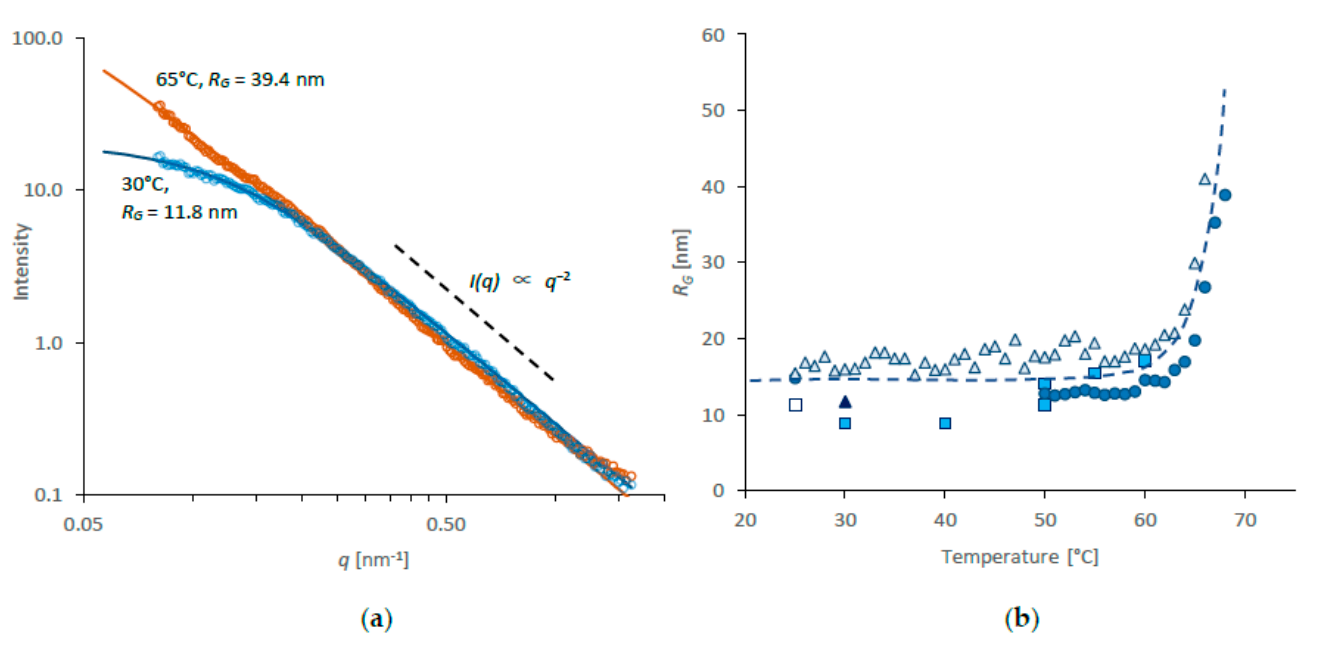
Figure 1. SAXS data for diluted NSF specimens: ( a ) individual markers represent intensity data (on logarithmic axes, to show the most important features) measured at 30 (blue)and 65 °C (brown); the continuous lines represent the Debye model (Equation (1)) with the values of R G shown; the dashed line shows the slope expected for ‘power law’ scattering from a polymer in solution; ( b ) values of R G obtained for diluted NSF during heating; the different shapes and colours represent different specimens; the dashed line merely provides a guide for the eye.